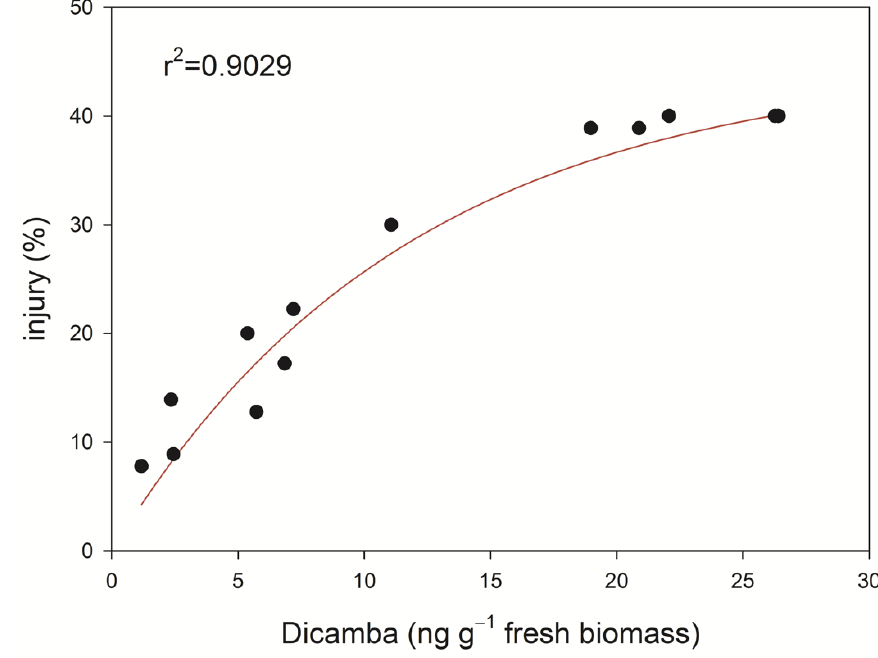
Figure 5. Regression fit between the mean soybean injury (%) and the dicamba concentrations in the plants at the related distances. Data points are the means of the replications, and the red line represents y = 44.85 ∗ (1 − exp ( − 0.085 ∗